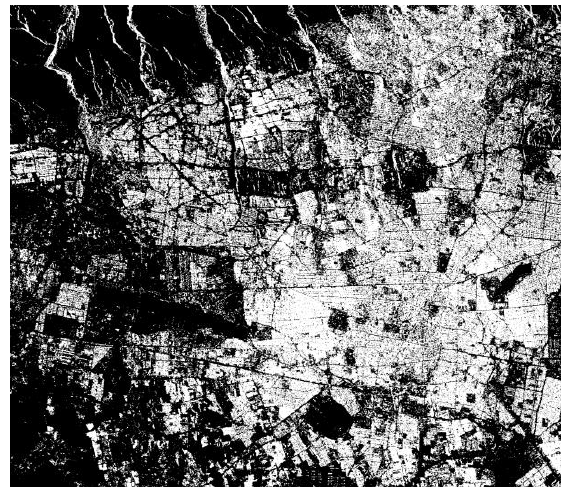
Figure 4. Classification of polarimetric bands and texture features of ALOS/PALSAR image (White: impervious surfaces, Black: non-impervious surfaces)